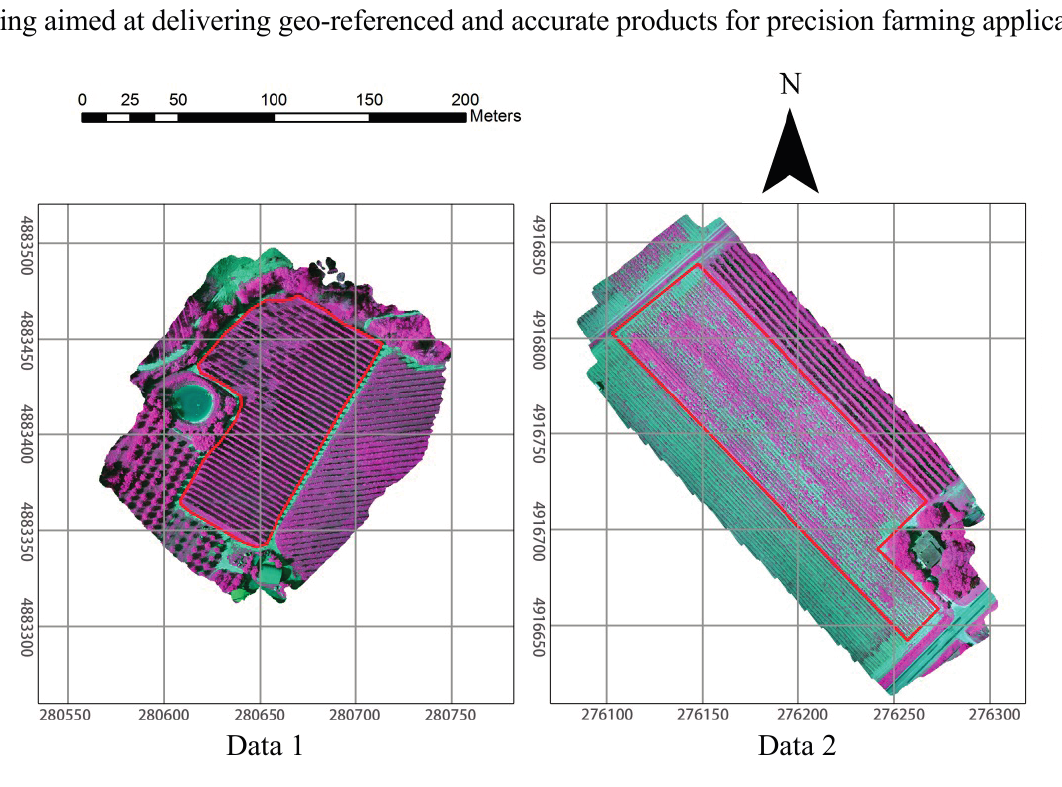
Figure 6. The obtained orthoimages (5 cm resolution) of the surveyed areas with the analyzed cultivation areas marked in